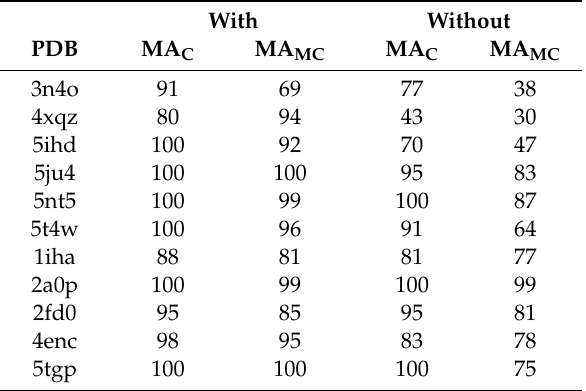
Table 3. MA C and MA MC for the eleven structures for which model and target sequences are equal or differ in one position, and for which the conditions R rh < 0.35 and R rh < R C are satisfied. WITH and WITHOUT indicate if the control on the sequences has been applied or not. MA values are percentages.